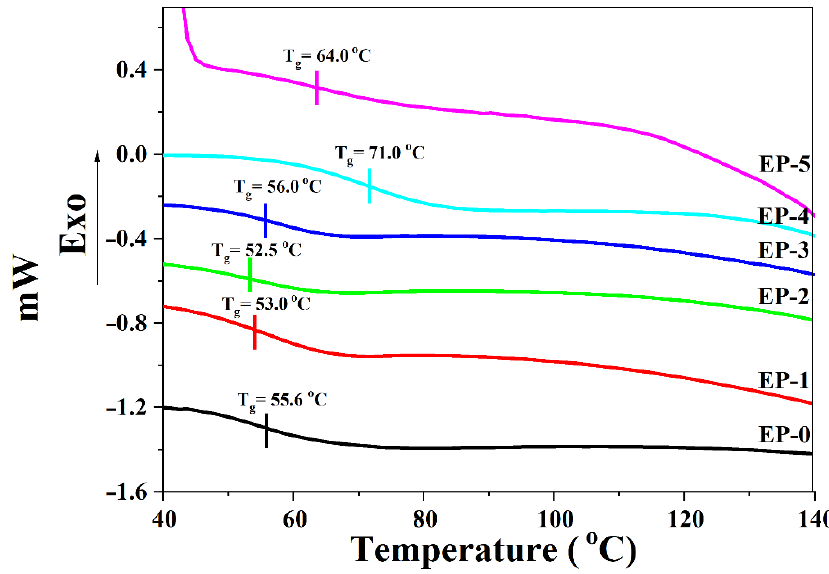
Figure 8. DSC curves of epoxy composites.